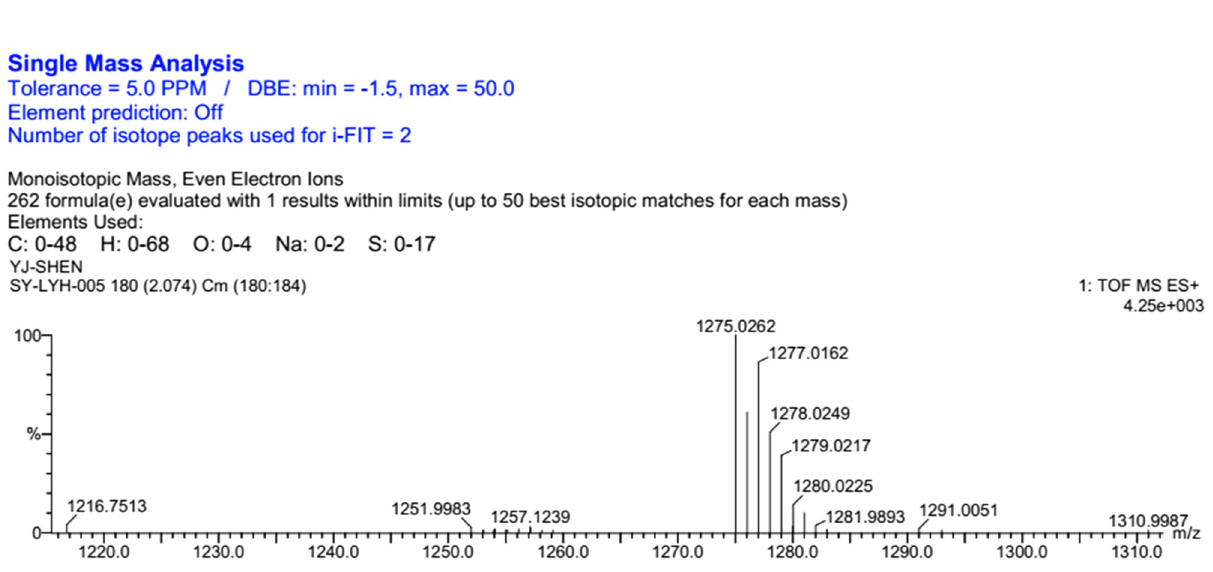
Figure A5: HRMS ( ESI ) of DTTF -